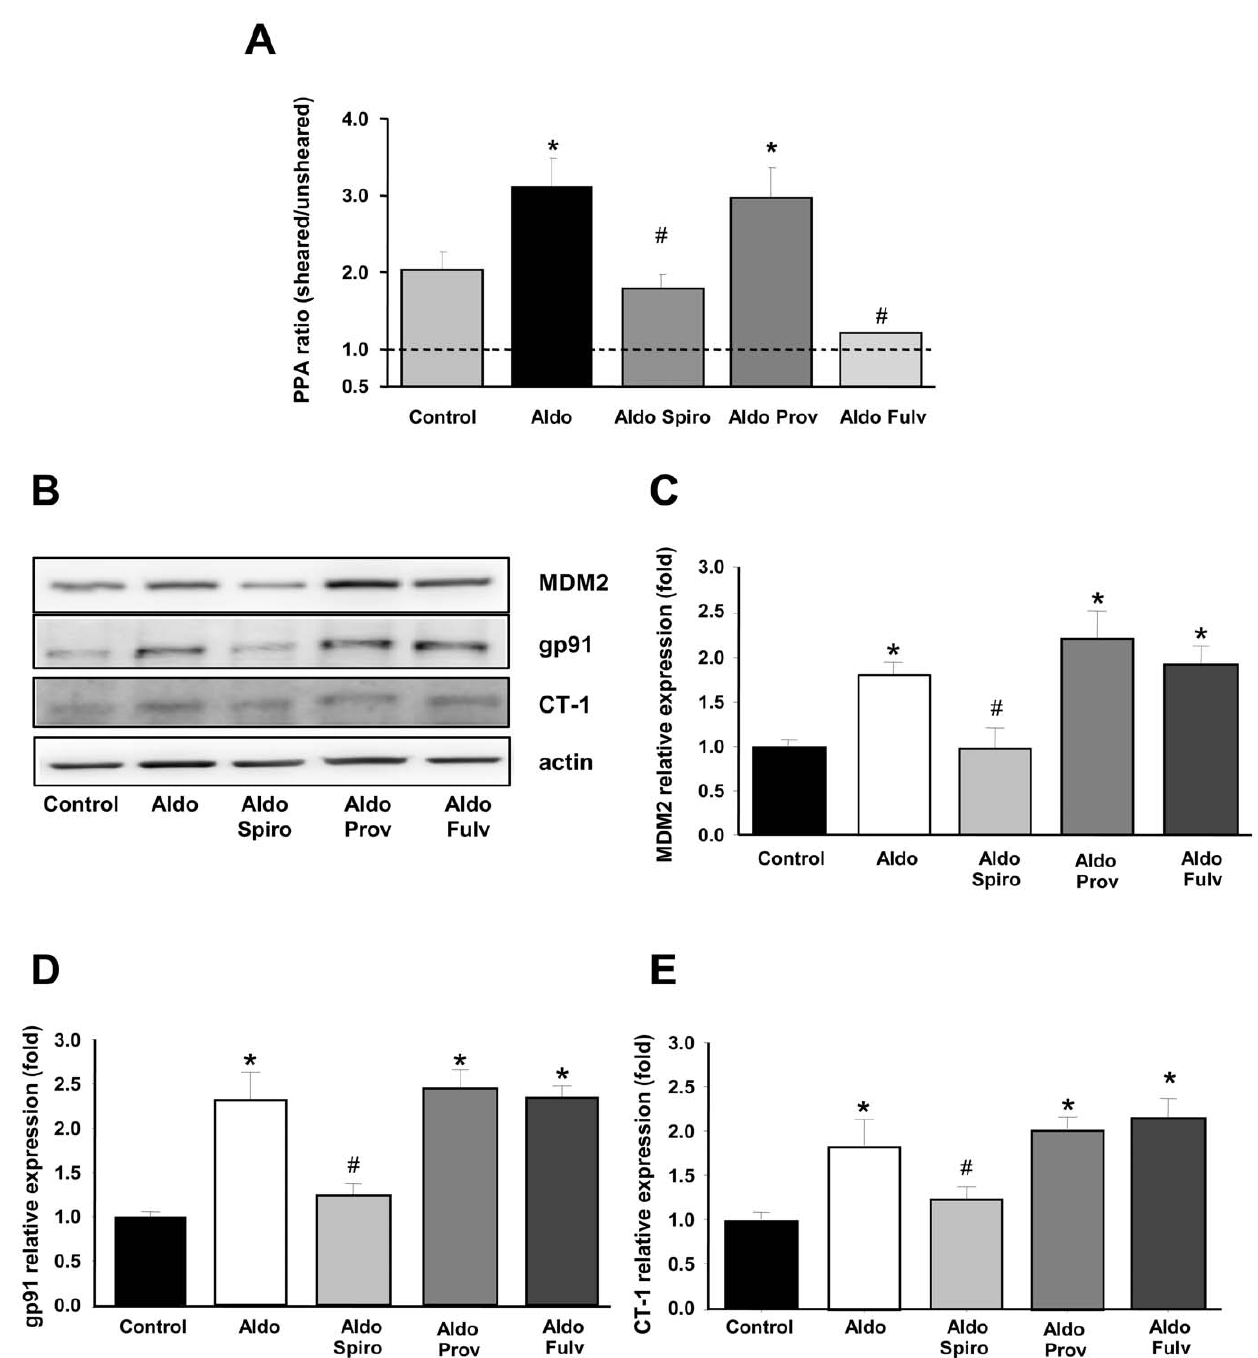
Figure 6. Shear stress and microparticle formation. (A) Phospholipid-related procoagulant activity (PPA) values are expressed as a ratio between sheared and unsheared data from blood samples treated with aldosterone (Aldo), aldosterone plus spironolactone (Aldo + Spiro) and aldosterone plus Provinols TM (Aldo + Prov) groups (n=4–5 for each group). Values are means 6 SEM, * P , 0.05 vs control (PBS). # P , 0.05 vs aldosterone-treated samples. (B-E). Mineralocorticoid receptor antagonist activity. VSMCs were preincubated with spironolactone (Spiro), Provinols TM (Prov) or fulvestrant (Fluv) for 1 hour, and then aldosterone (Aldo) was added for 24 hours for protein analysis. Changes in MDM2 (C), gp91 (D) and CT-1 (E) protein expression were assayed by Western Blotting and normalized with b -actin in triplicate. A representative Western blot (B) and the histograms with bars represent the means 6 SEM of triplicates in three independent experiments. * P , 0.01 vs Control. doi:10.1371/journal.pone.0039235.g006 that hypertrophy of the media had occurred. The increased dry not quantified here (principally proteoglycans and glycoproteins) weight reflects not only the increase in smooth muscle cell and deduced by substraction. The significant increase in aortic content but also an increase in some extracellular components dry weight due to aldosterone-salt was not observed under co-